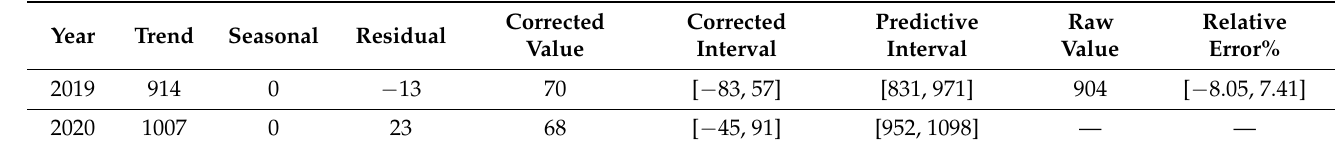
Table 9. Predictive results of the death toll range in housing municipal engineering production safety